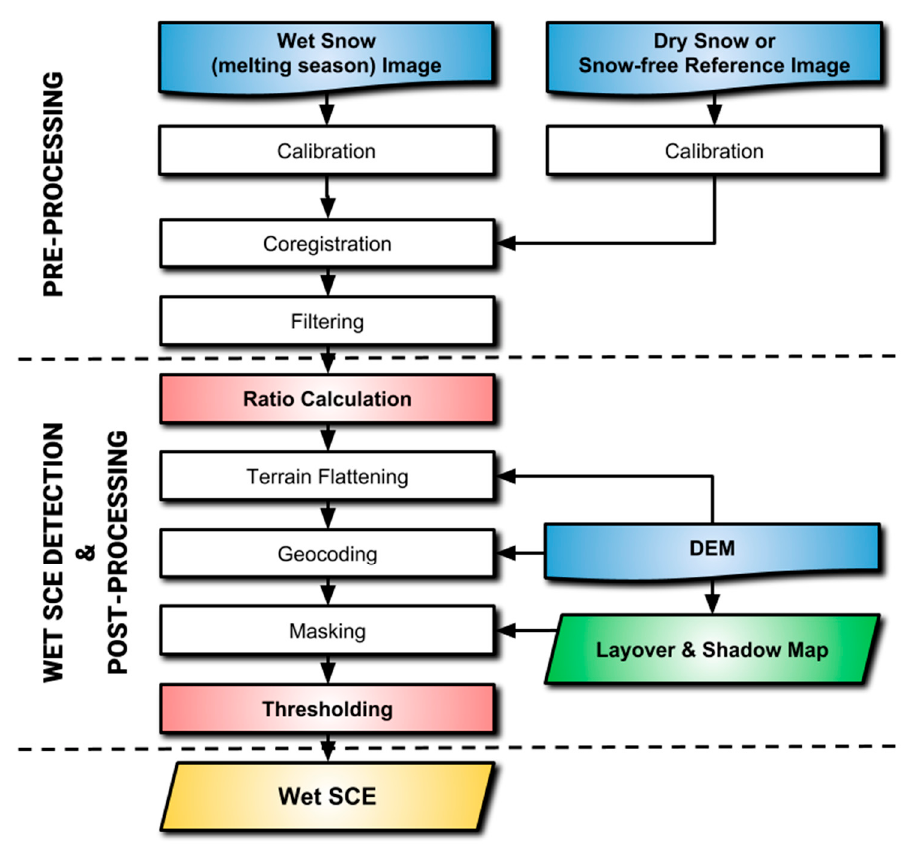
Figure 6. The overall workflow of the backscattering-based algorithm to detect wet snow.